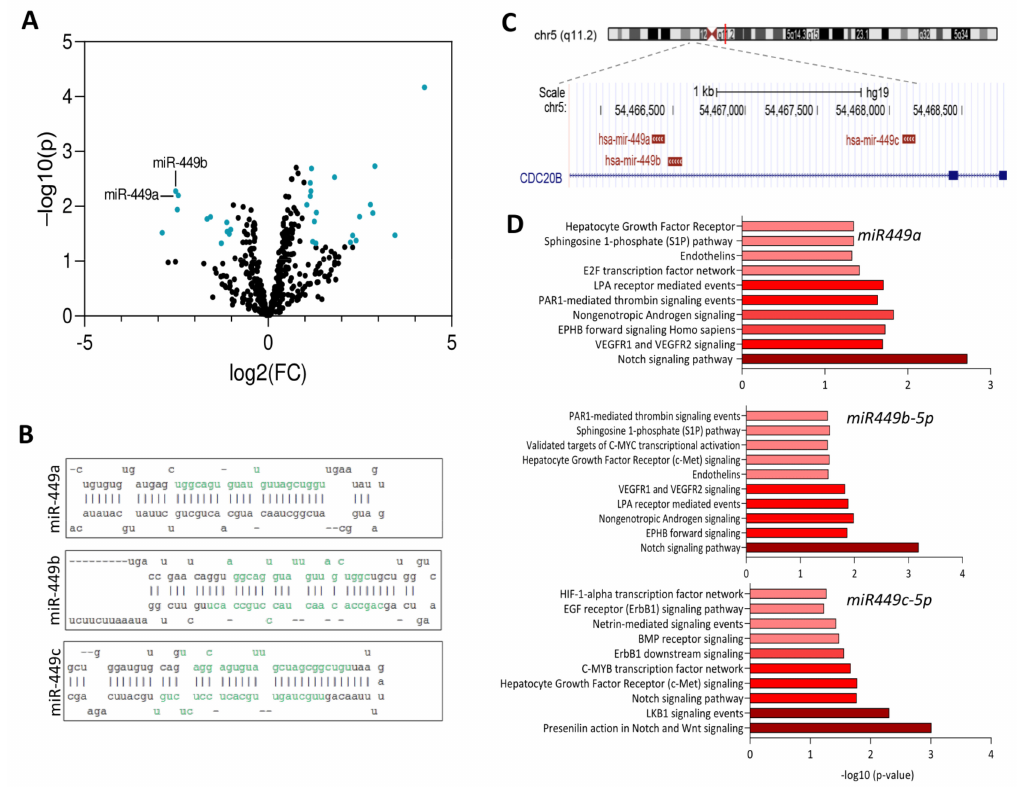
Figure 1. The miR-449 family is associated with enhanced NOTCH signaling in T2E+ PCa. ( A ) Volcano plot of miRNAs [22] with log2(fold changes) annotated on the x -axis and − log10( p -values) annotated on the y -axis. ( B ) Sequences and structures of miR-499a, -b, and -c (mirbase.org). ( C ) Location of miR449a, -b, and -c on chromosome 5 (genome.ucsc.edu). ( D ) Bargraph of signaling pathways affected by predicted target genes of miR-449a, miR-449b-5p and